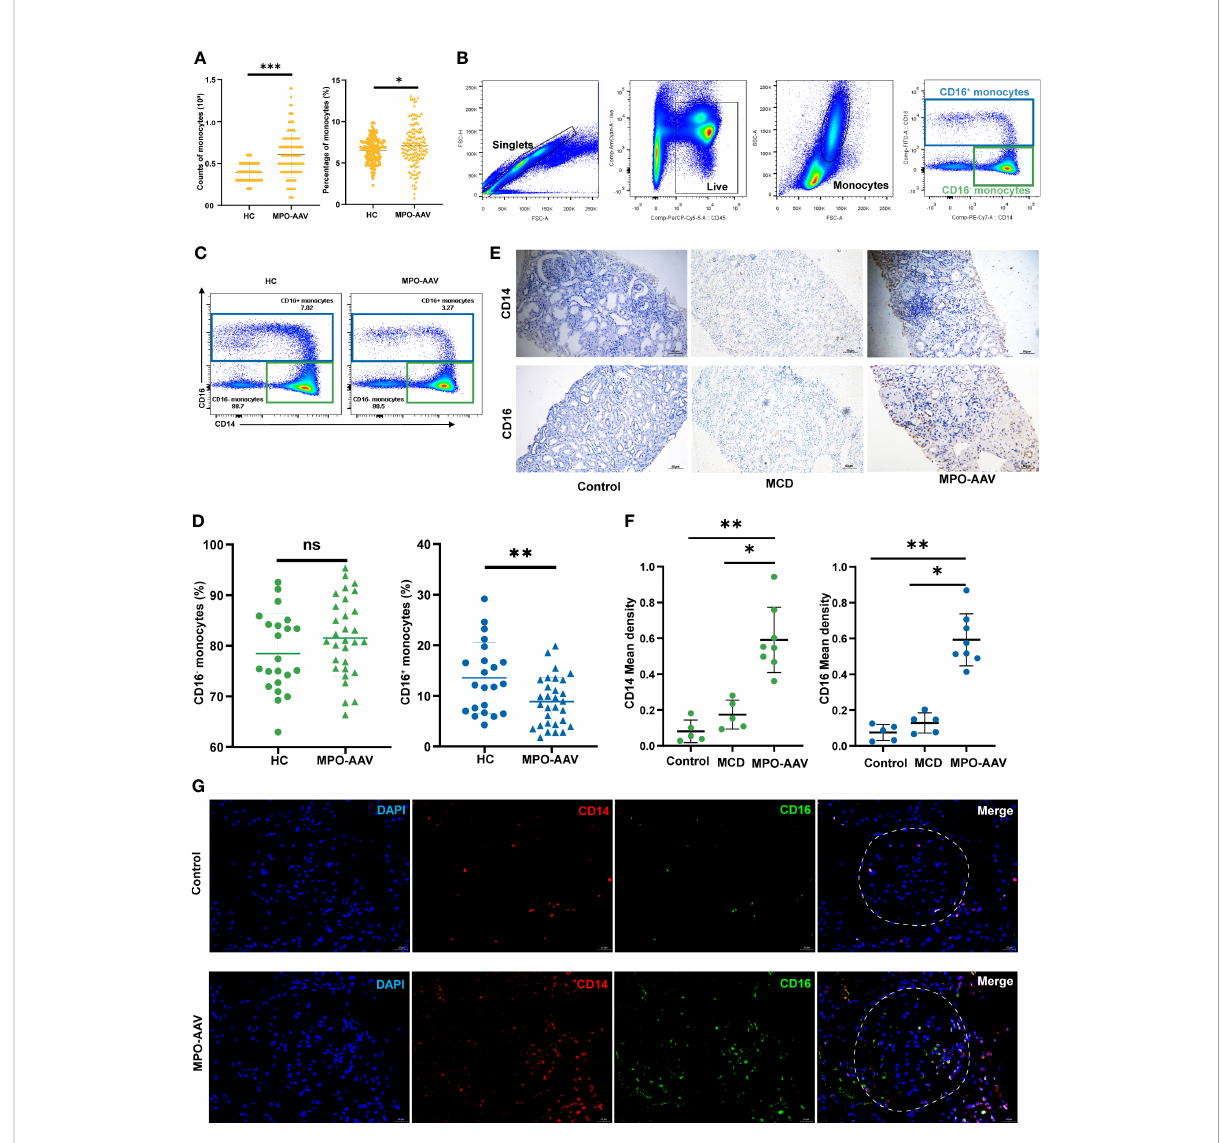
FIGURE 1 CD16 + monocytes abundance in the peripheral blood and kidneys of MPO-AAV patients with renal damage. (A) Signi fi cant differences in the monocytes in the blood of AAV patients and healthy controls (HC) were observed. (B) The abundance of monocyte subsets in PBMC from MPO-AAV patients (n=30) and HC (n=22) was analyzed by fl ow cytometry. Monocytes were identi fi ed within the FSC-A hi and SSC-A hi cell populations and the gate strategy was based on CD14 and CD16 expression; (C) Representative fl ow cytometry dot plots show the subsets of monocytes in MPO-AAV patients and HC; (D) The percentage of CD16 + and CD16 - monocytes in the peripheral blood of MPO-AAV patients and HC was shown. (E, F) Representative kidney sections showing CD14 + and CD16 + cells in MPO-AAV patients, patients with MCD, and control; (F) Quanti fi cation of CD14 + and CD16 + cell in fi ltrates in the kidneys of MPO-AAV patients (n=8), patients with MCD (n=5), and control (n=5). (G) CD14 + CD16 + cells (orange) abundance was signi fi cantly increased in the glomeruli (white dotted line) of MPO-AAV patients than in control. ns, not signi fi cant. * p <0.05; ** p <0.01; *** p